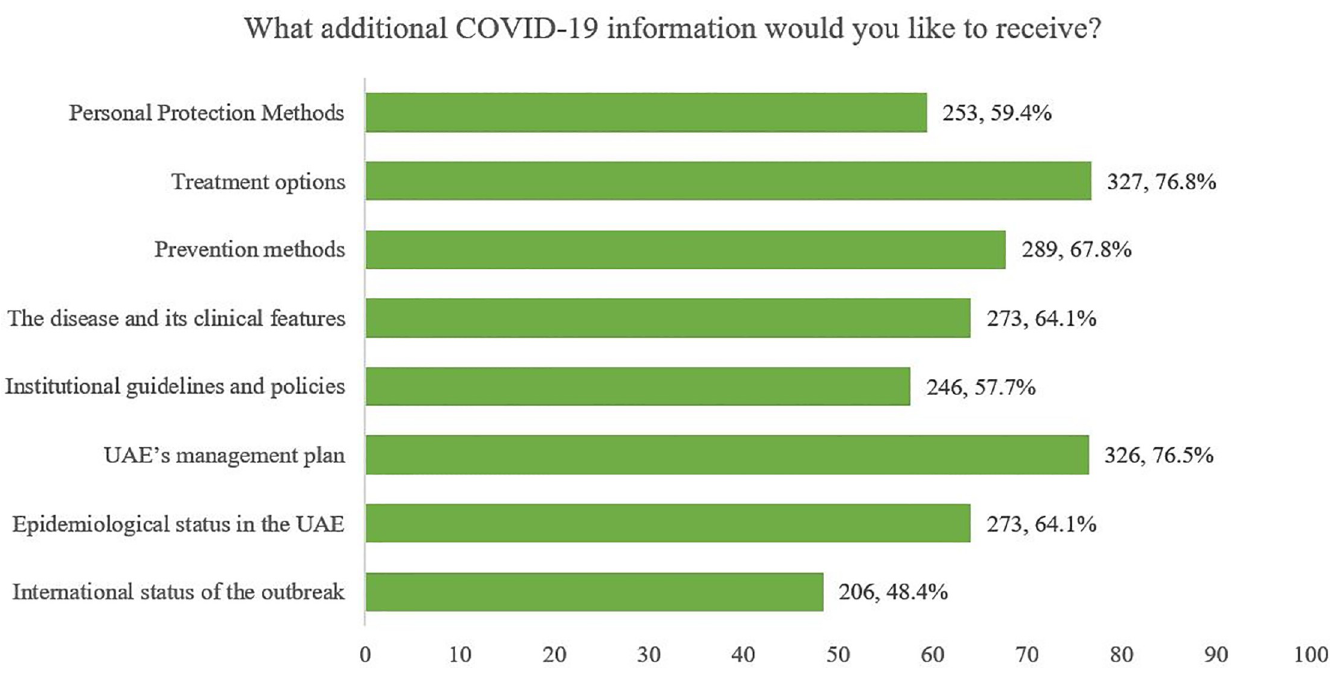
Fig 3. Additional COVID-19 information participants would like to